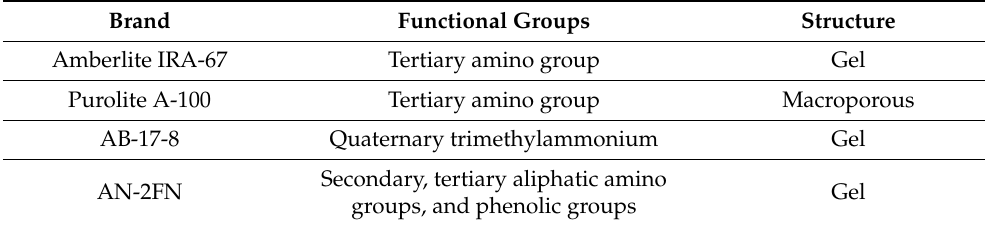
Table 1. Characteristics of anion exchangers. Brand Functional Groups Structure Amberlite IRA-67 Tertiary amino group Gel Macroporous Quaternary trimethylammonium Gel Secondary, tertiary aliphatic amino groups, and phenolic groups